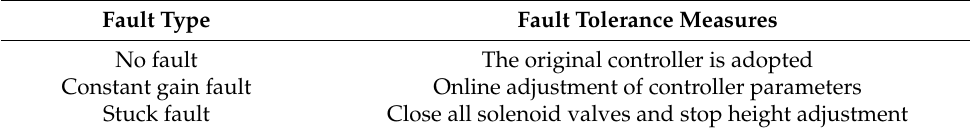
Figure 8. Active fault tolerant control strategy of vehicle ECA system. Table 4. Contents of active fault tolerant control decision